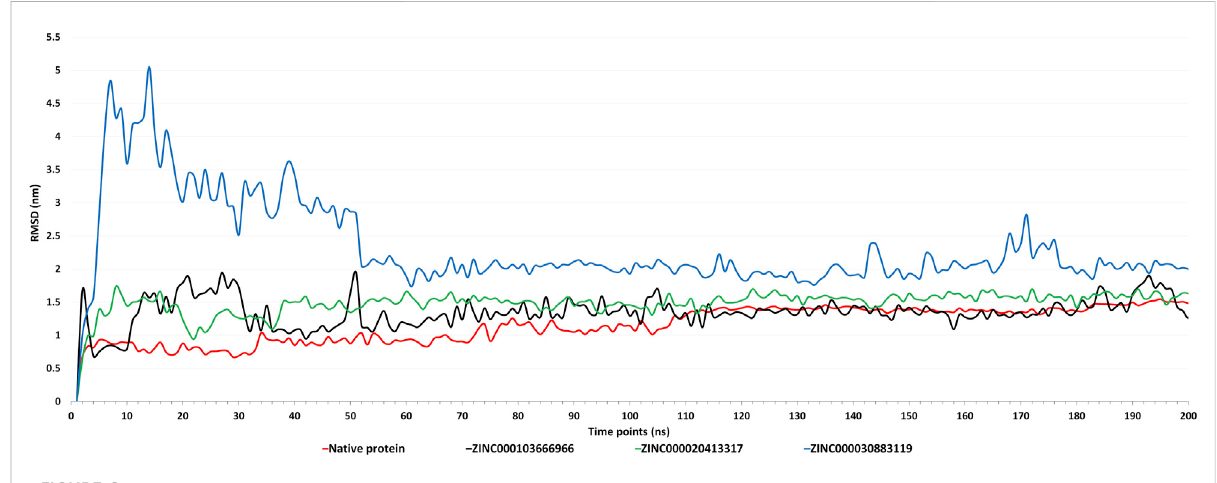
FIGURE 6 Figure showing the graphs of Root Mean Square Deviation (RMSD) of native protein (apoform) and complexes with molecules ZINC000103666966, ZINC000020413317, and ZINC000030883119 for the MD simulations of 200